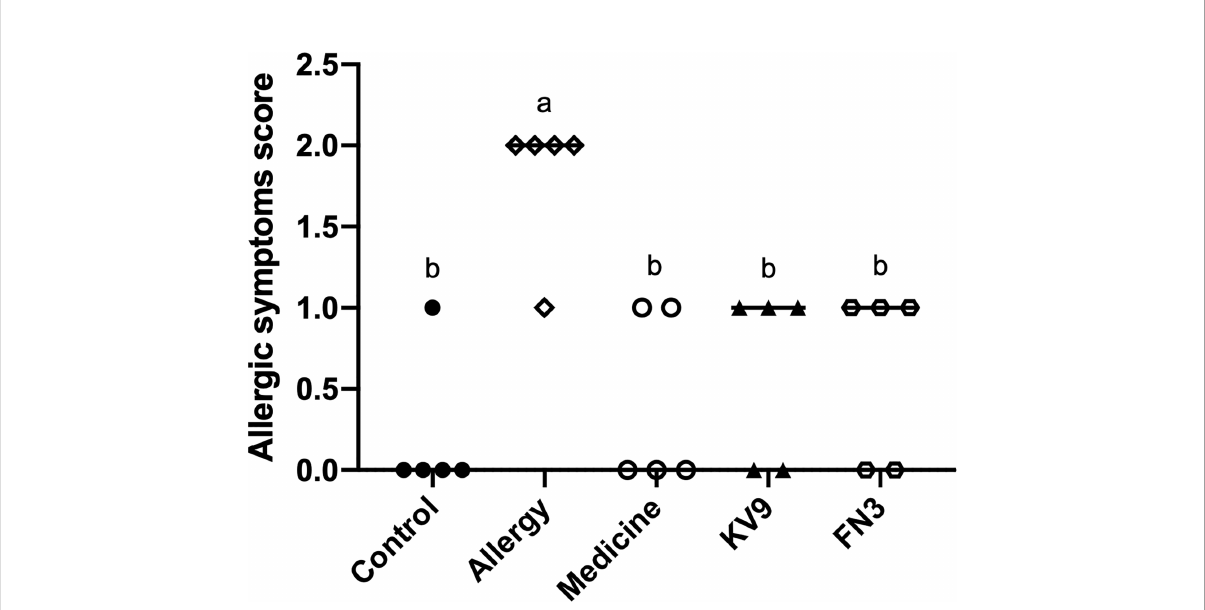
FIGURE 2 Allergic symptom scores in mice. Identical lowercase in the fi gure indicates the lack of signi fi cance ( p < 0.05).